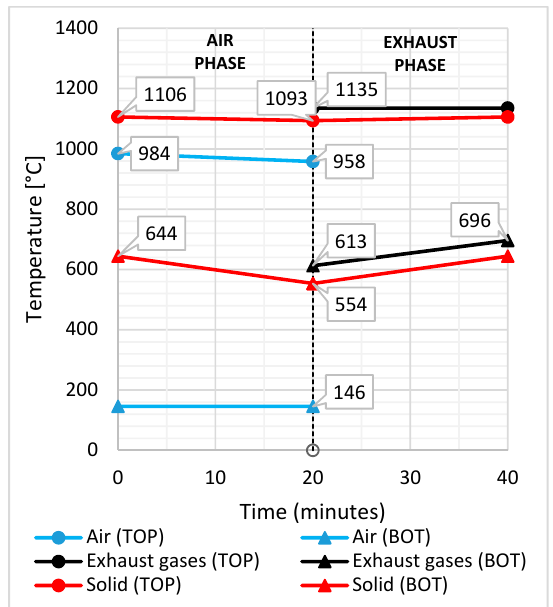
Figure 5. Temperatures variation with time at the top and bottom of the RC (reference case).